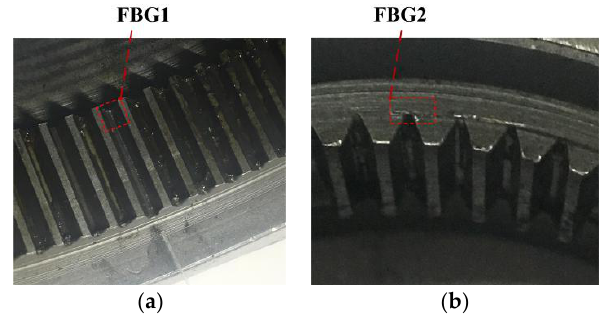
Figure 17. Installation of ( a ) FBG1 and ( b ) FBG2 in the experiment.